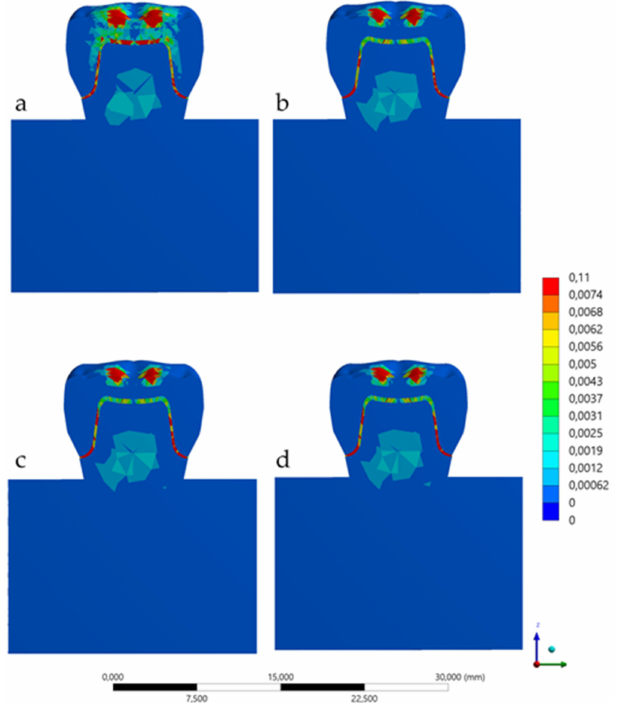
Figure 8. Strain energy (mJ) in the set according to the PC material: ( a ) PEKK; ( b ) Titanium; ( c ) CoCr; and ( d )